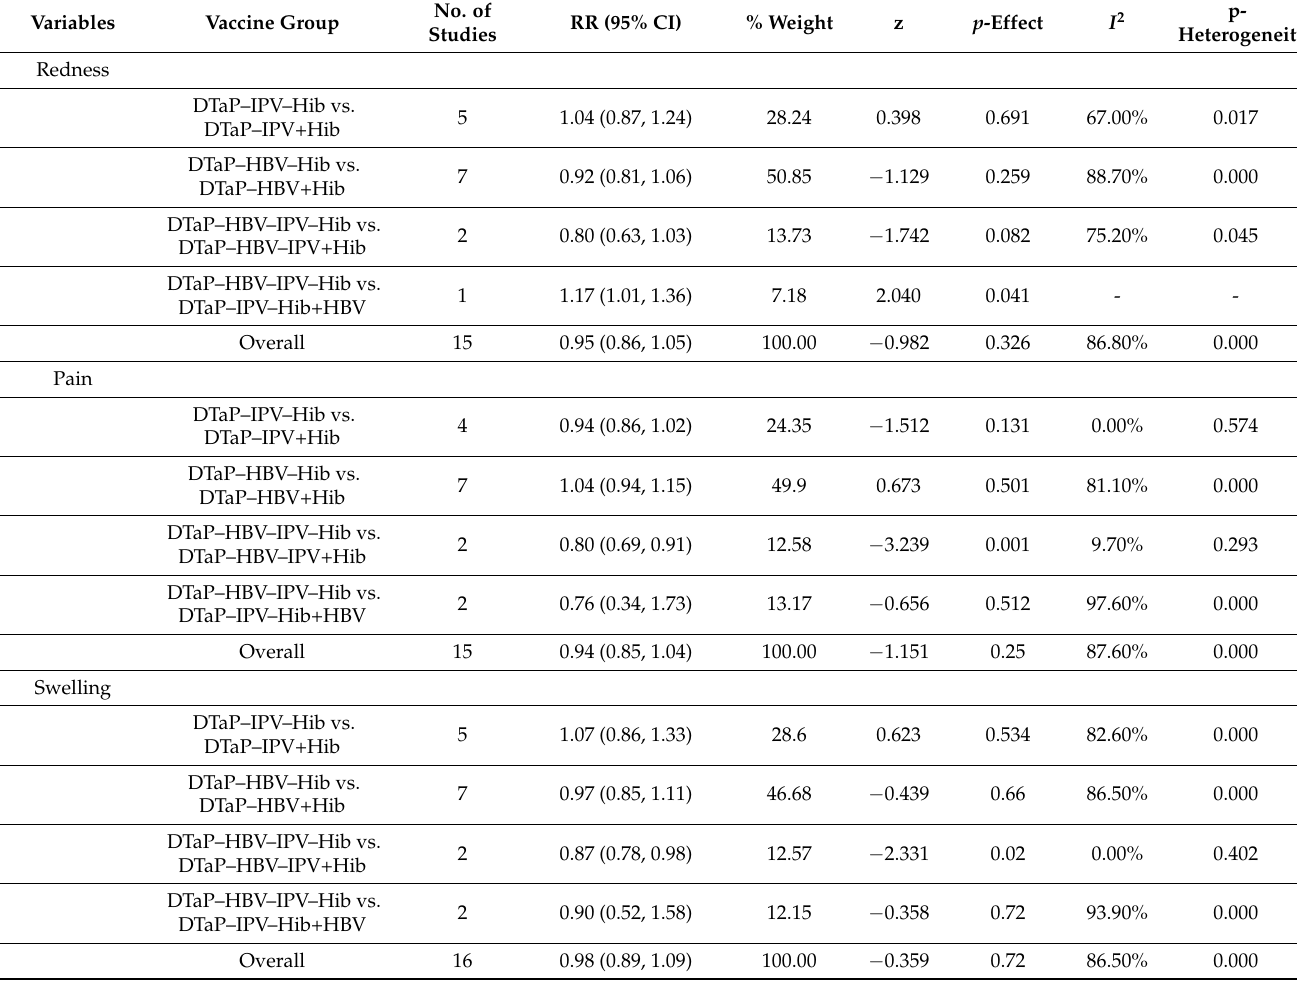
Table 3. The meta-analysis of local and systemic reactions of different types of combined